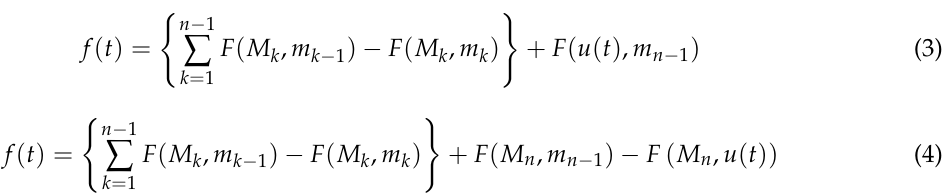
Figure 6. The explanation of area T ( α 1 , β 1 ) on the Preisach plane.